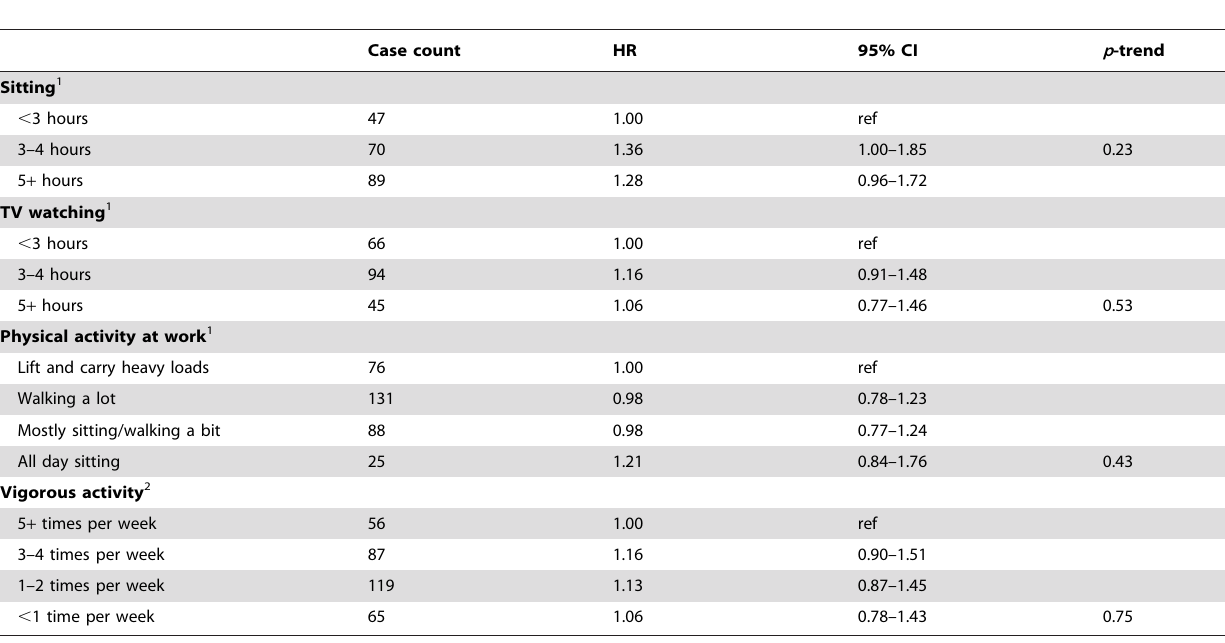
Table 4. Hazard ratios (HR)and 95% confidence intervals (CI) between sedentary behaviors and physical activity and lung cancer risk among never smokers, NIH-AARP Diet and Health Study